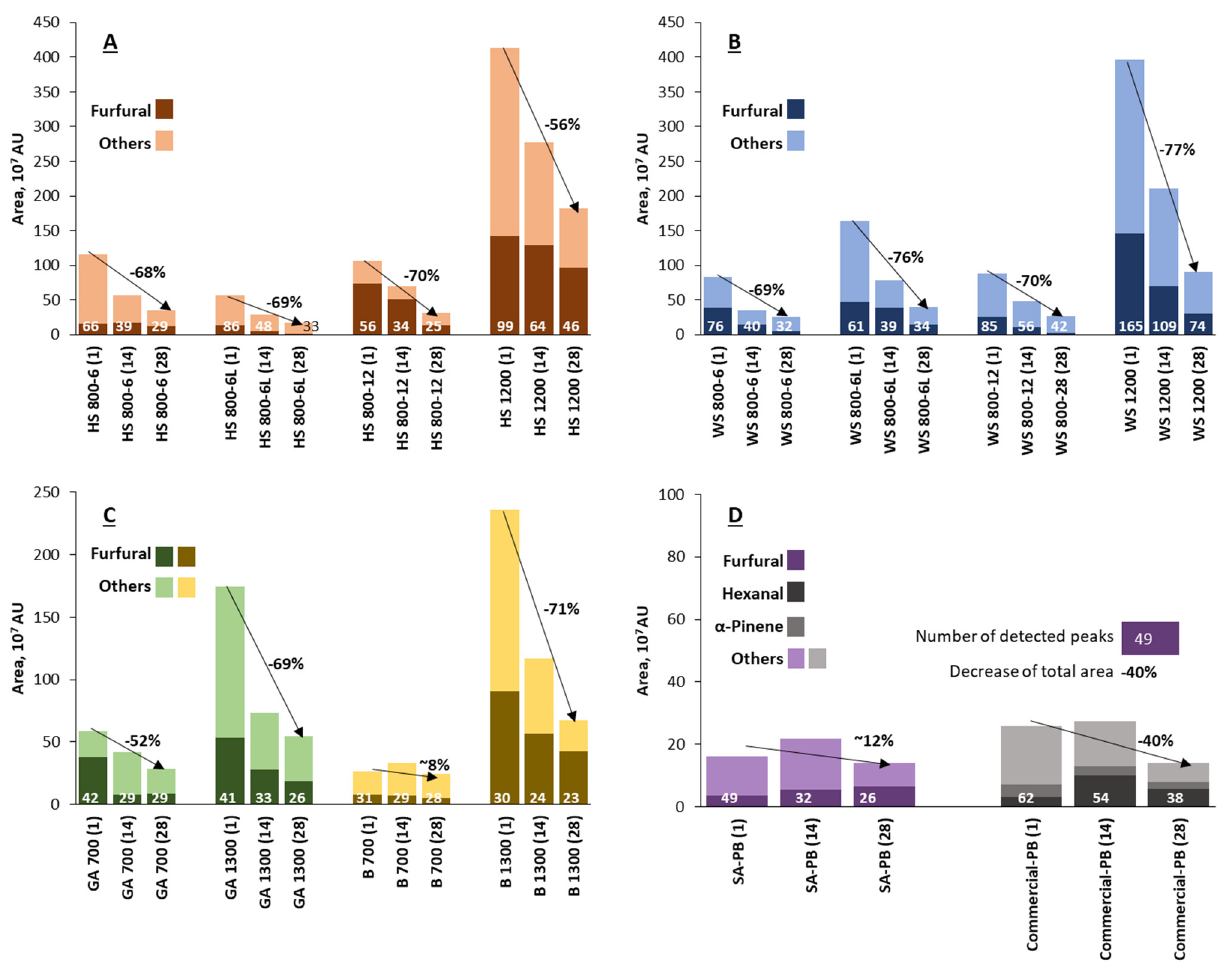
Figure 4. Semi-quantitative comparison of the total VOCs and the furfural fraction emitted from the bio-based boards after days 1, 14, and 28, depending on the raw material, density, thickness, and overlaying. Binder-less boards from ( A ) hemp shives, ( B ) wheat straw, ( C ) grey alder and birch wood, ( D ) suberinic acids-bonded and commercial particleboards.